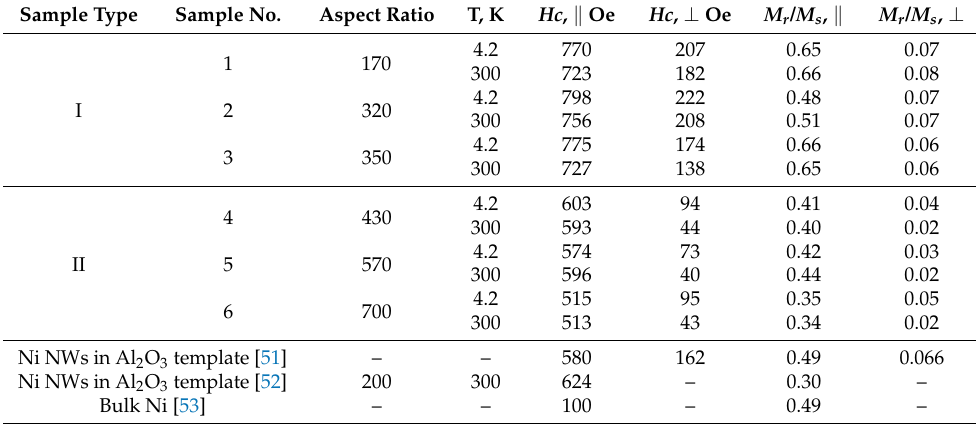
Figure 6. Normalized axial ( A , B ) and in-plane ( C , D ) hysteresis loops for Ni NWs at 4.2 K ( A , C ) and 300 K ( B , D ). The insets show increased magnetization fragments near zero H . Table 4. A comparison of the coercivity and squareness of the hysteresis loops for Ni NWs in MPAA with different aspect ratios at 4.2 and 300 K